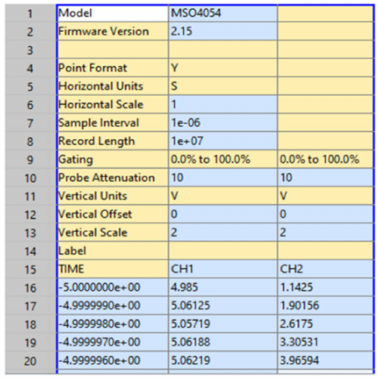
Figure 10. Measurement data—extract.